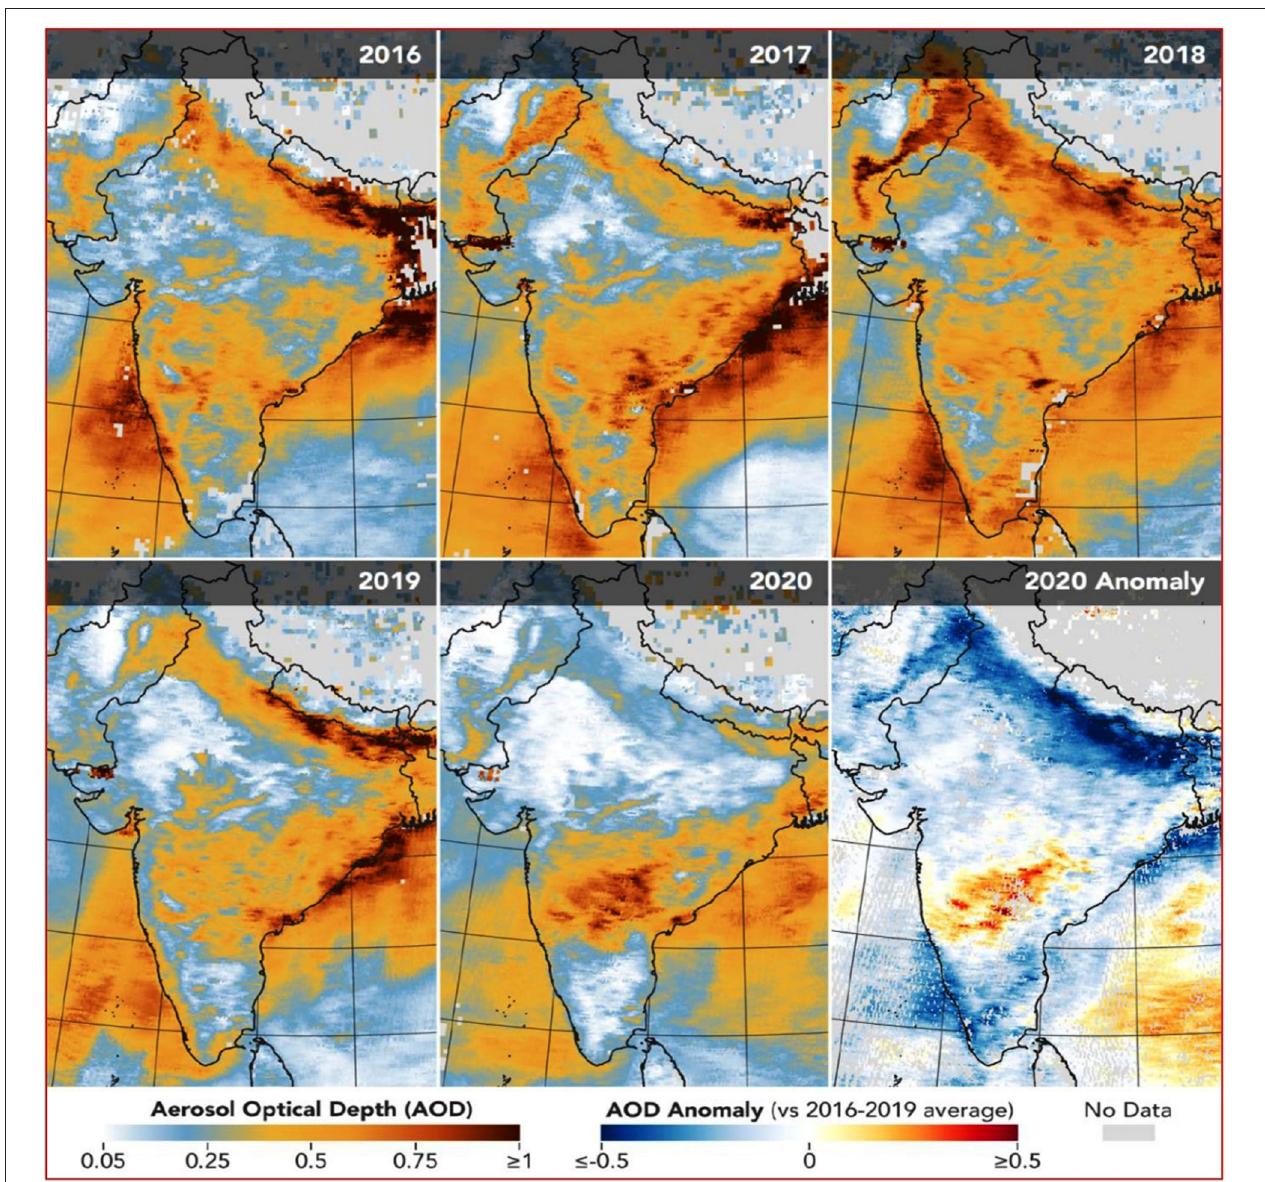
FIGURE 4 | Pre- and post-lockdown level of airborne aerosols over India Source: NASA and ESA, (source, https://earthobservatory.nasa.gov/images/146596/ airborne-particle-levels-plummet-in-northern-india, https://earthobservatory.nasa.gov/. accessed date: 13 May 2020).